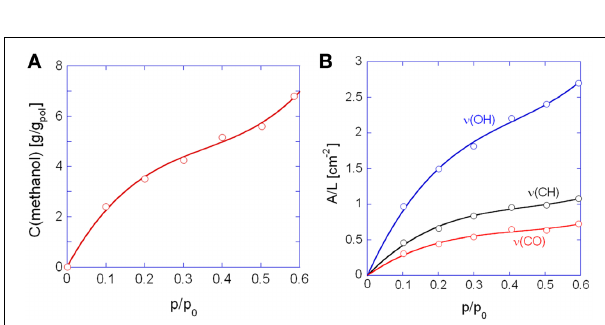
Figure 6 | Sorption isotherms as a function of the relative pressure of methanol. (A) Gravimetric measurements; (B) spectroscopic measurements. In (B) are reported the curves obtained with the indicated bands of methanol. Solid lines are for eye guidance only.